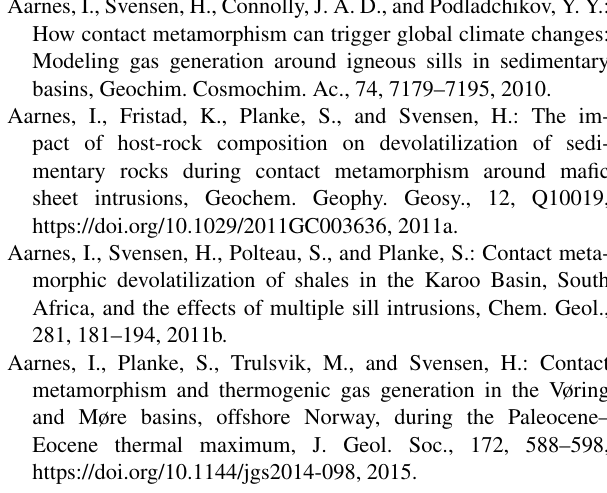
Model output includes peak temperature profiles,